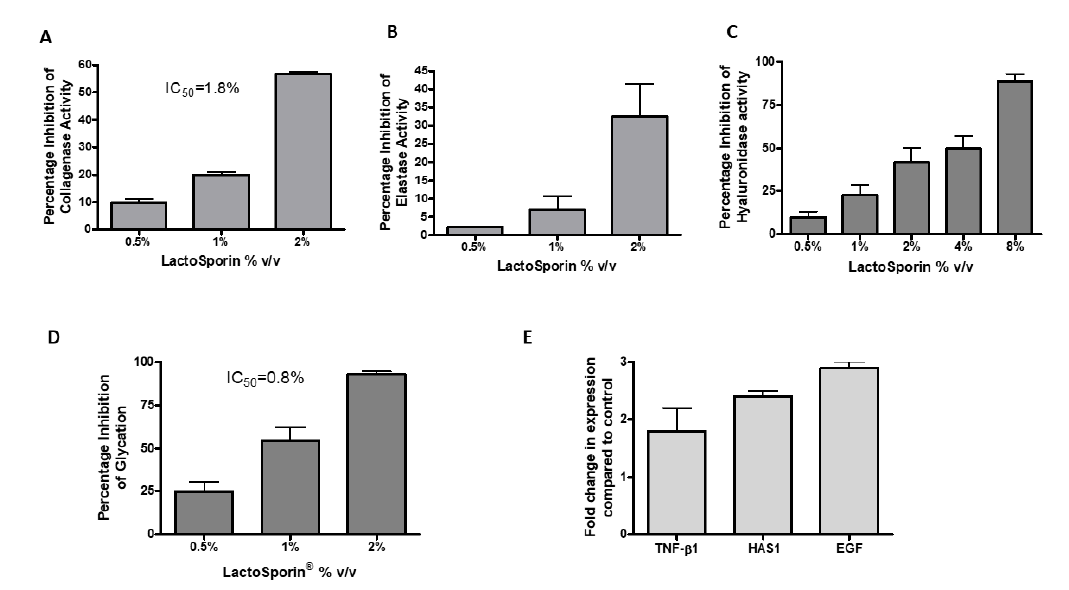
Figure 4. Effect of various concentrations of LactoSporin in preserving the extracellular membrane layer. ( A ) Percentage inhibition of collagenase activity; ( B ) Percentage inhibition of elastase activity; ( C ) Hyaluronidase enzyme inhibition; ( D ) Percentage inhibition of advanced glycation end products (AGEs) and ( E ) Gene expression study of transforming growth factor (TGF)- β , hyaluronic acid synthase (HAS1), and epidermal growth factor (EGF). Data are represented as Mean ± SD, n = 3.